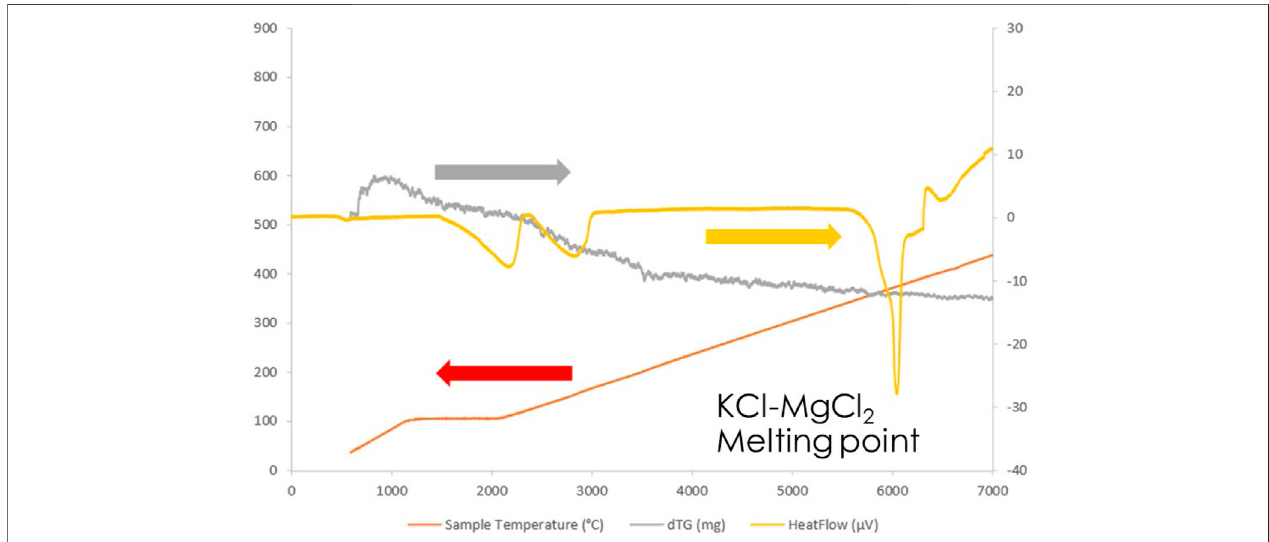
FIGURE6| Thermogravimetricanalysisofpuri fi edcarnallite.Thered lineistheheatingpro fi leofthesample,withthetemperaturesshown in ° Contheleftaxis.The grey line shows the mass loss in mg and the yellow line shows the heat fl ux in μ V on the right axis.